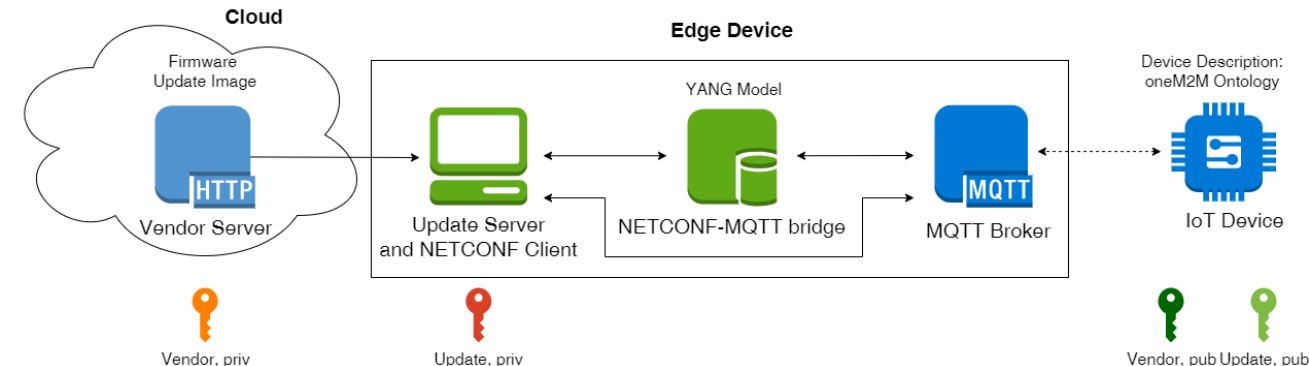
Figure 1. System architecture of the MYNO